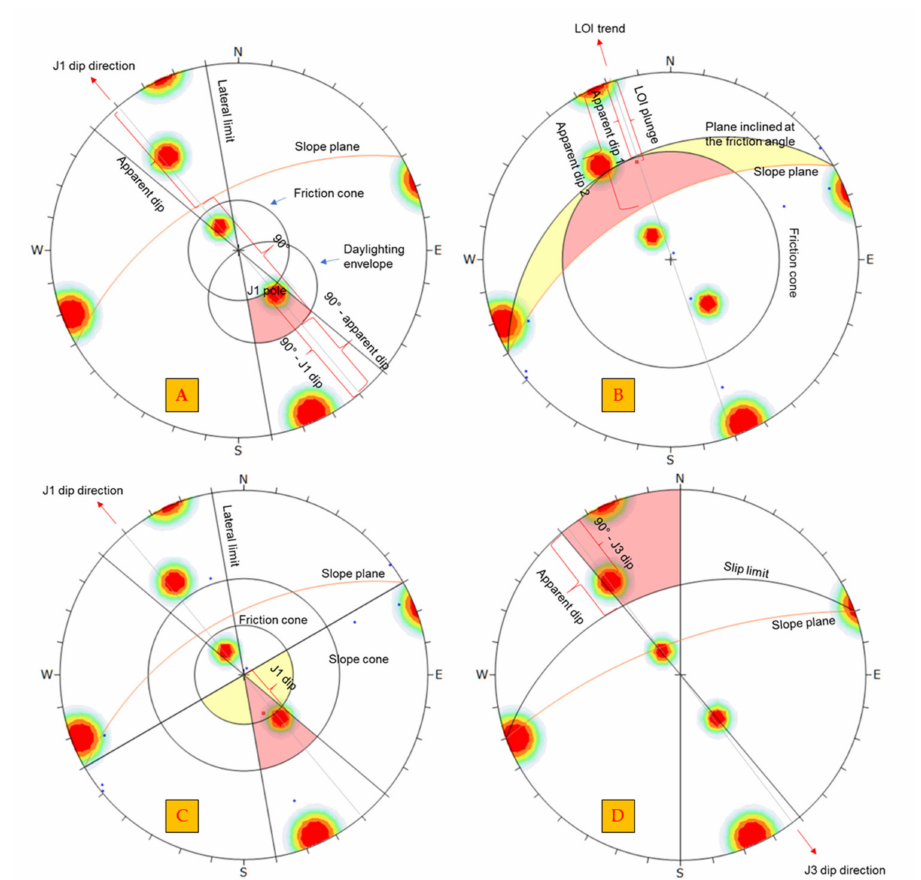
Figure 5. Graphic representation of GIS-based kinematic stereonet analysis to evaluate the potential of a slope for different modes of instability, including ( A ) planar, ( B ) wedge, ( C ) direct toppling, and ( D ) flexural toppling